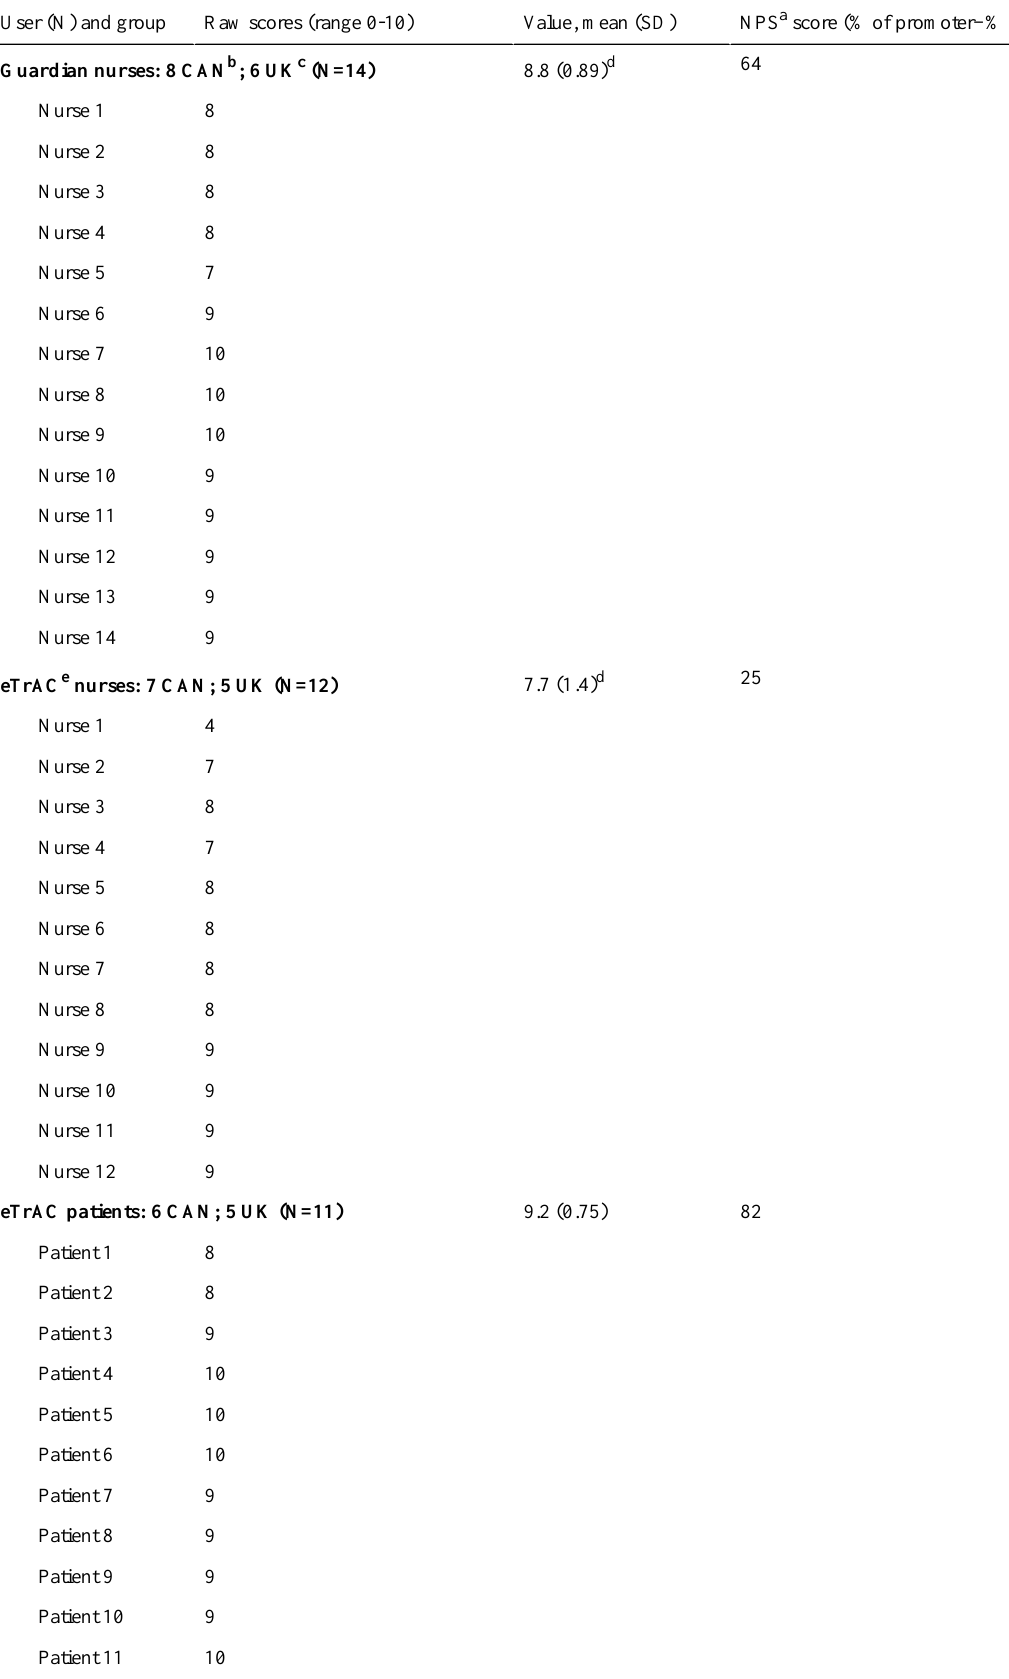
Table 4. User satisfaction—Net Promoter Scale